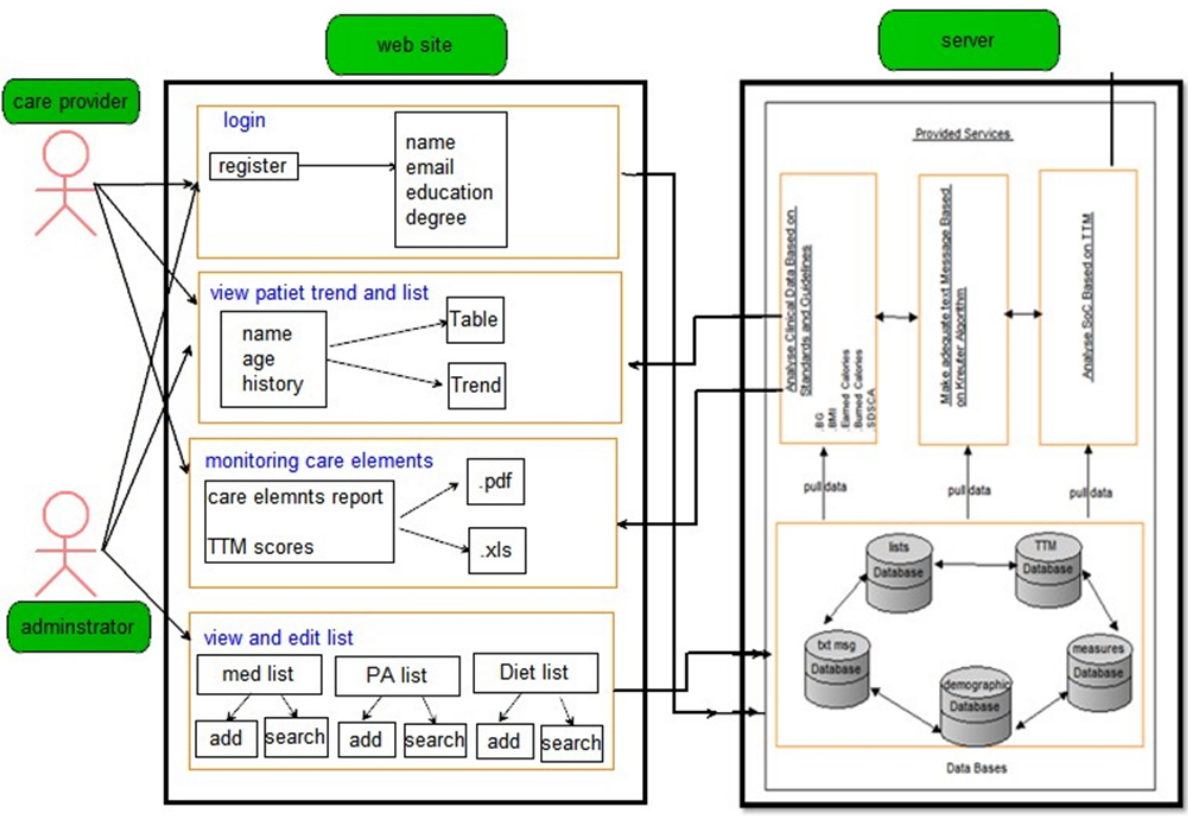
Figure 2. Proposed architectural framework for functionalities of a system for health care